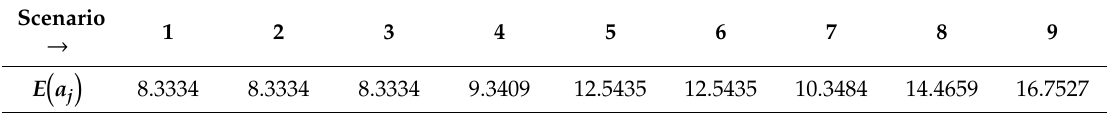
Table 11. Utility values matrix given climate